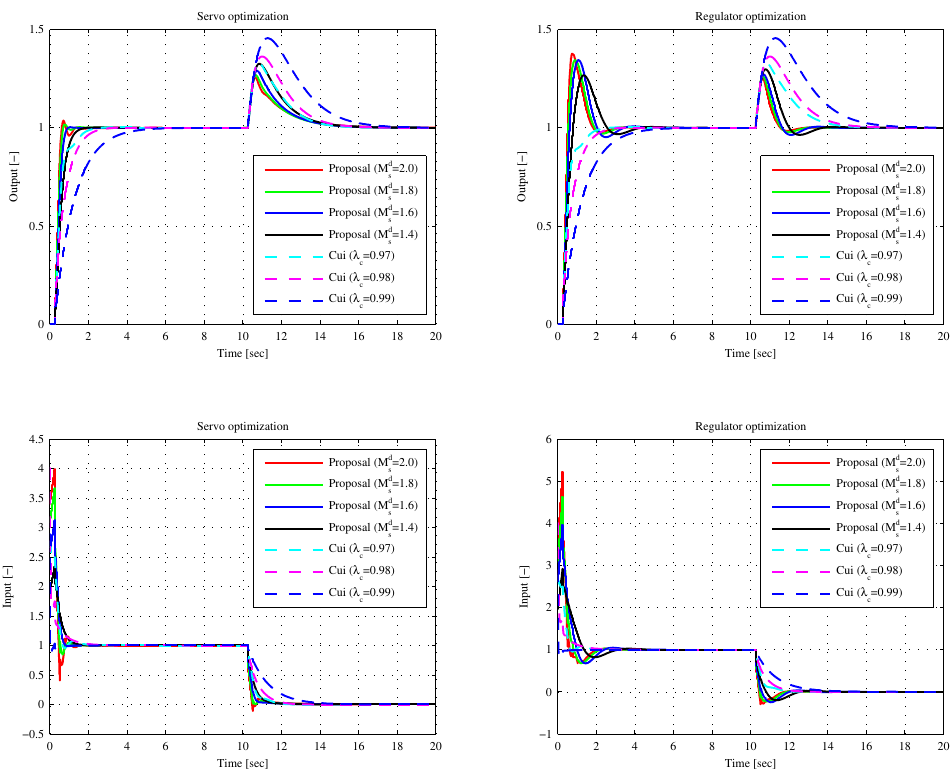
Figure 8. Results of the IMC-based method and the proposed servo and regulator optimization methods, where the system is disturbed by a unit step disturbance after 10 s; left: servo optimization; right: regulator